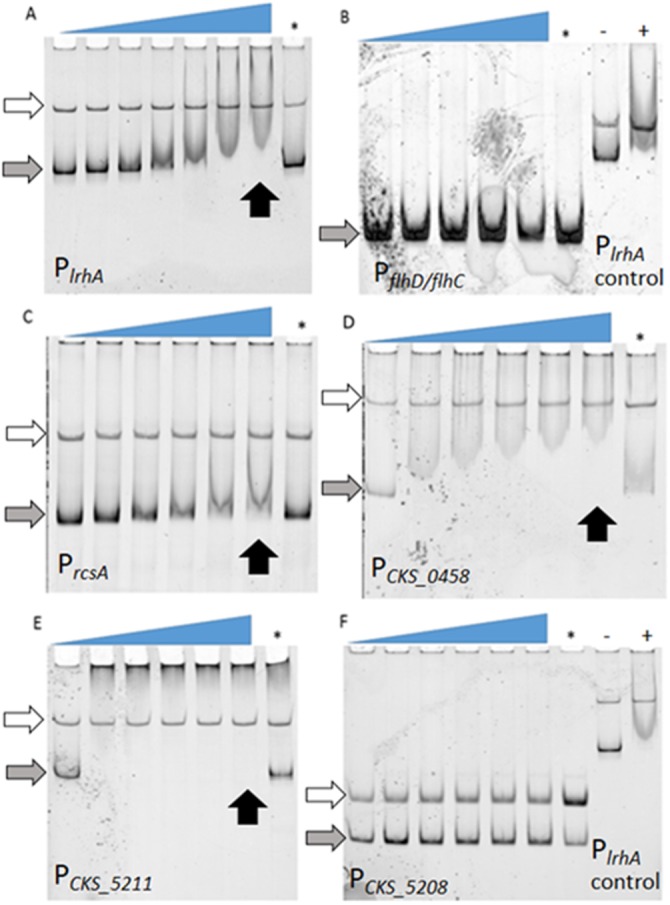
Examination of binding of LrhA to select target promoters via EMSA.FAM-DNA probes were incubated with increasing concentrations of His6-LrhA (LrhA) from left to right, corresponding to the slope of the triangles, to investigate the mobility shift upon specific binding to the protein. The competition reaction (indicated by the asterisk, ∗) was conducted with 25 nM unlabeled DNA of PlrhA to prove the specificity of the interaction. Autoregulation of LrhA was confirmed with the direct binding between purified LrhA to its promoter (A). Shifted bands were also observed with PrcsA (C), PCKS_0458 (D), and PCKS_5211 (E). There were no shifted bands observed for PflhDC (B) and PCKS_5208 (F), while the positive controls for LrhA activity showed a shift (−: reaction with PlrhA probe in the absence of LrhA, +: reaction with PlrhA probe in the presence of 200 nM LrhA). Concentrations of LrhA tested for PlrhA (A) are 0, 25, 50, 100, 200, 400, and 800 nM. Concentrations of LrhA tested for PflhDC (B) are 0, 400, 600, 800, and 1,000 nM. Concentrations of LrhA tested for PrcsA (C), PCKS_0458 (D), PCKS_5211 (E) and PCKS_5208 (F) are 0, 200, 400, 600, 800, and 1,000 nM. Grey arrows highlight unbound DNA probes. White arrows indicate unbound DNA generated during PCR reactions that do not interact specifically with LrhA. Black arrows point to the lane with specific binding at the highest concentration of LrhA.